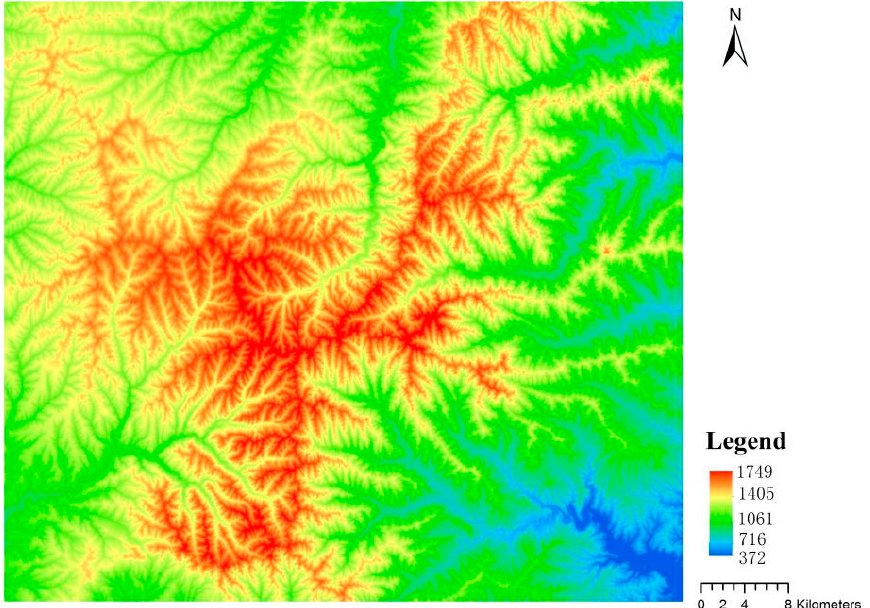
Figure 5. DEM of the test area.